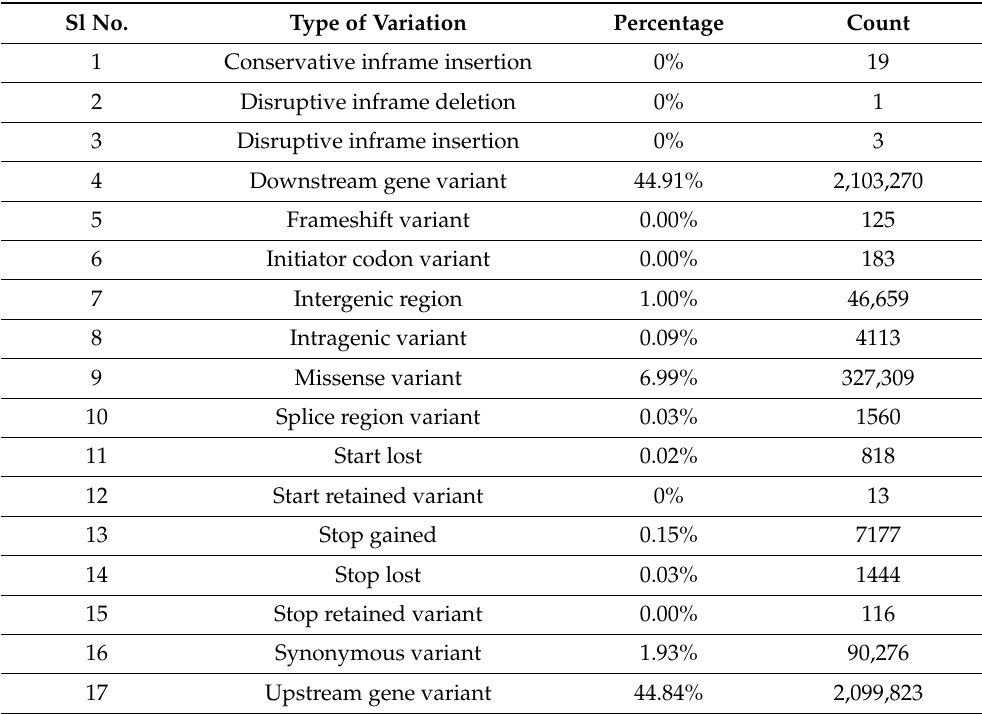
Table 1. A detailed tabular presentation of types of variations occurring in Mycobacterium tuberculosis , along with its count and